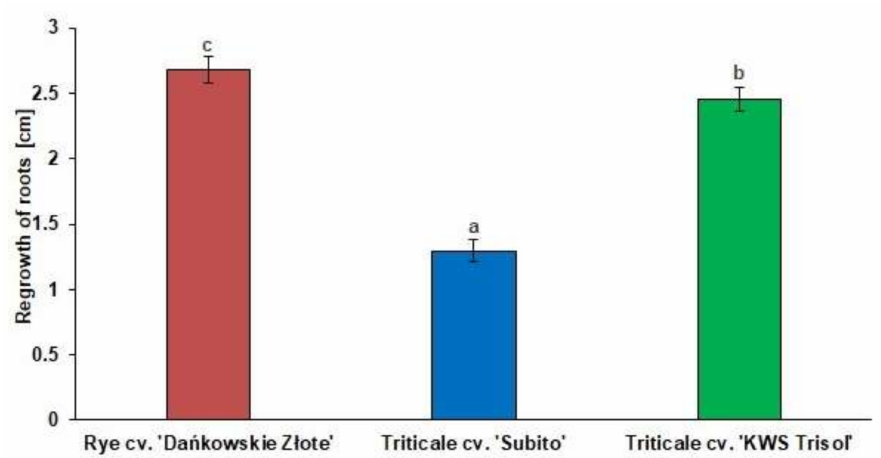
Figure 1. The regrowth of cereal roots after treatment with Al 3+ (0.59 mM) for 24 h. Results are shown as means ± confidence intervals. Different letters indicate significant differences among values after one-way analysis of variance and Tukey’s honestly significant difference procedure at p